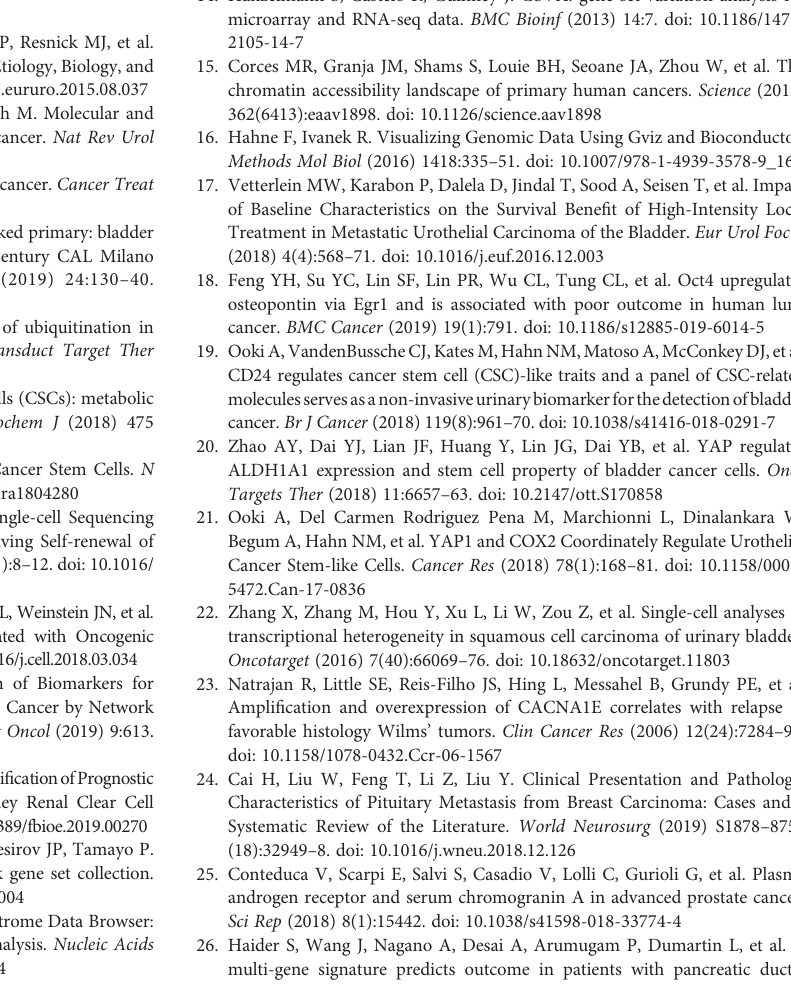
Supplementary Figure 2 | Construction of the prognostic nomogram with 205 objectives and treating age as a categorical variable. (A) The constructed prognostic nomogram based on the multivariate Cox model. (B) The calibration curve illustrated acceptable calibration of the prognostic nomogram. The time-related ROC with 95% con fi dence interval (C) , decision curve (D) and residual plot (E) were also conducted to illustrate the patient bene fi t and the discrimination of the nomogram. Note: (***P < 0.001; **P < 0.01; **P < 0.05). Supplementary Figure 3 | Construction of the prognostic nomogram with all 403 objectives with all available variables and missing values. (A) The constructed prognostic nomogram based on the multivariate Cox model. (B) The calibration curve illustrated acceptable calibration of the prognostic nomogram. The time- related ROC with 95% con fi dence interval (C) , decision curve (D) and residual plot (E) were also conducted to illustrate the patient bene fi t and the discrimination of the nomogram. (***P < 0.001; **P < 0.01; **P < 0.05). Supplementary Figure 4 | Construction of the prognostic nomogram with all 403 objectives with all missing values and available variables except for age and gender. (A) The constructed prognostic nomogram based on the multivariate Cox model. (B) The calibration curve illustrated acceptable calibration of the prognostic